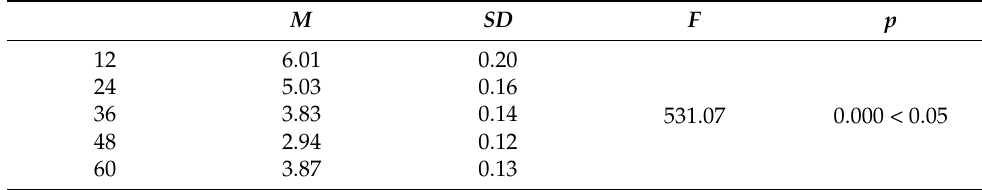
Table 7. Time statistic value under intensity